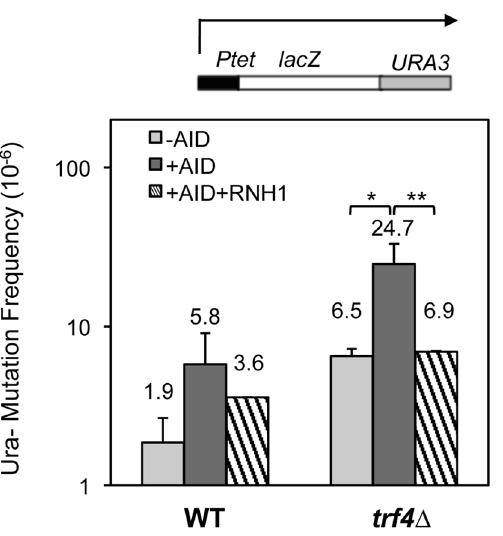
Figure 7. Spontaneous and AID-induced mutation frequencies in wild-type and trf4 D strains. Mutation frequency of W303-1A (WT), TRF4D-C5 ( trf4 D ) strains, using the LAUR fusion construct. Ura - mutants are selected in SC + FOA. The human AID gene was overexpressed in 2% galactose medium using plasmid p413GALAID. The median values of mutation frequencies and SD of 3–4 different fluctuation tests are shown. Asterisks indicate statistically significant differences, according to Student’s t tests (*, P , 0.05; **, R ,